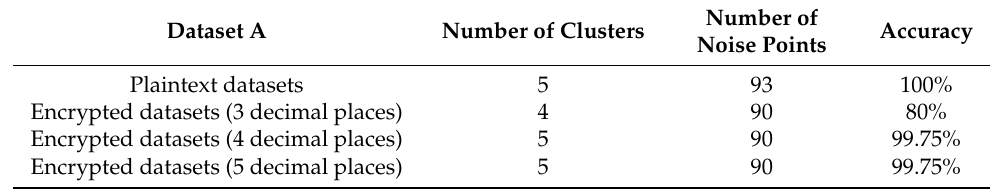
Table 2. Comparison of plaintext and ciphertext clustering results for dataset A. Dataset A